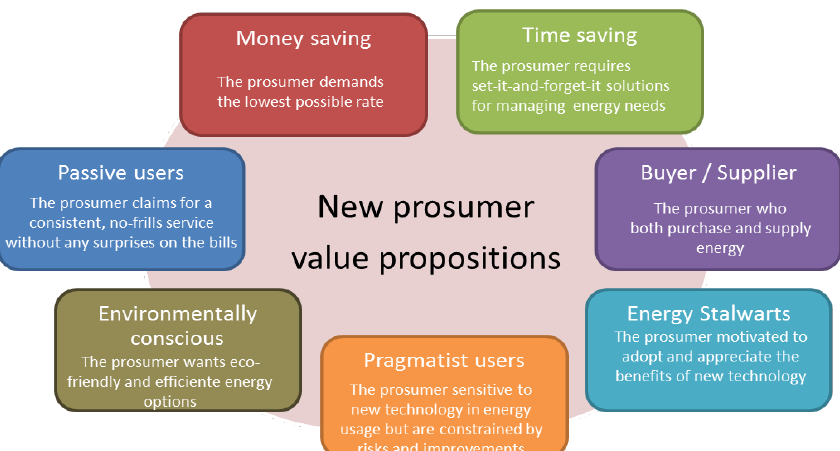
Figure 7. New prosumer value